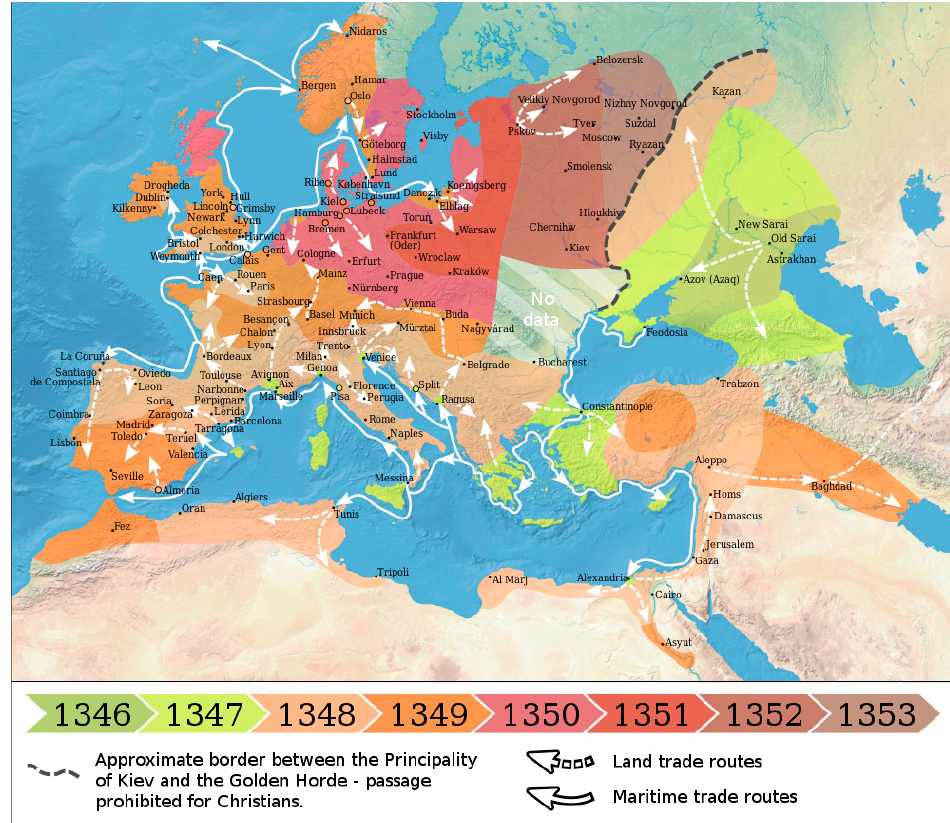
Figure 2. Spread of the Black Death in Europe and the Near East (1346–1353). The contagion route can be easily followed from East to West: In the summer, the Black Death arrived in Constantinople; in September, it arrived in Alexandria; by October, it was already in Sicily, and in January 1348, it arrived in Venice, Genoa, and Marseille. It reached Barcelona in May, Valencia and Almer í a in June [43], and upon reaching the British Isles and the Scandinavian Peninsula, it had covered Europe from end to end. Source: By Flappiefh—Own work from Natural Earth; The origin and early spread of the Black Death in Italy: first evidence of Plague victims from 14th-century Liguria (northern Italy) maps by O.J. Benedictow., CC BY-SA 4.0, https://commons.wikimedia.org/w/index.php?curid=66468361, accessed on 27 July